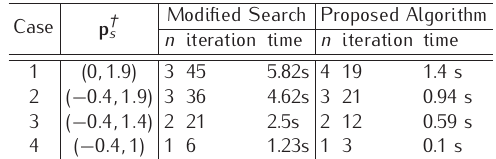
Table 2. Results of the Modified and Proposed